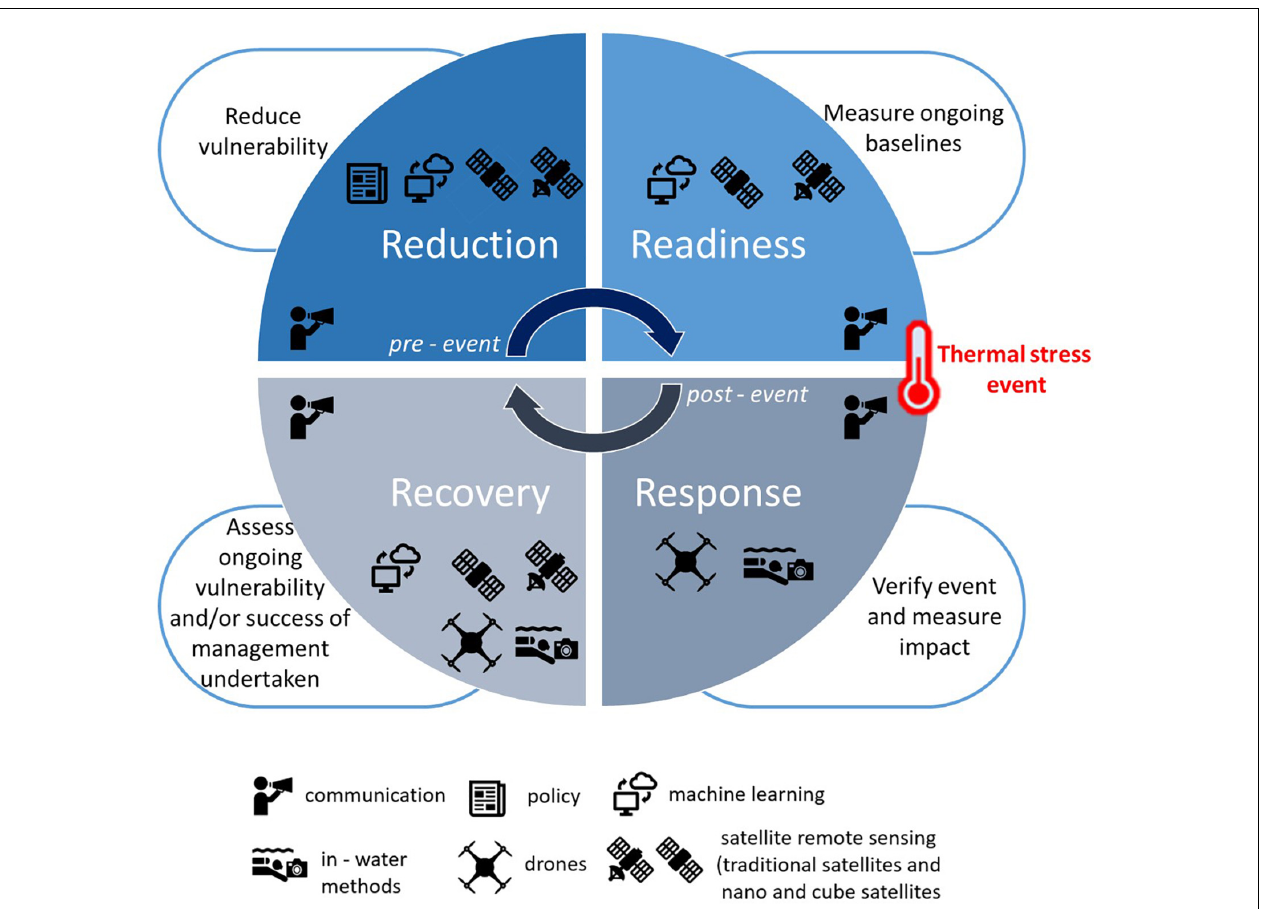
FIGURE 2 | Traditional risk management strategy utilized to develop a mechanism to respond to increasing thermal stress on coral reefs and the potential coral bleaching response. Reduction and readiness form the pre-event phases, whilst recovery, and response, the post-event phases. The tools best suited for each stage are depicted, communication is shown as required throughout the whole